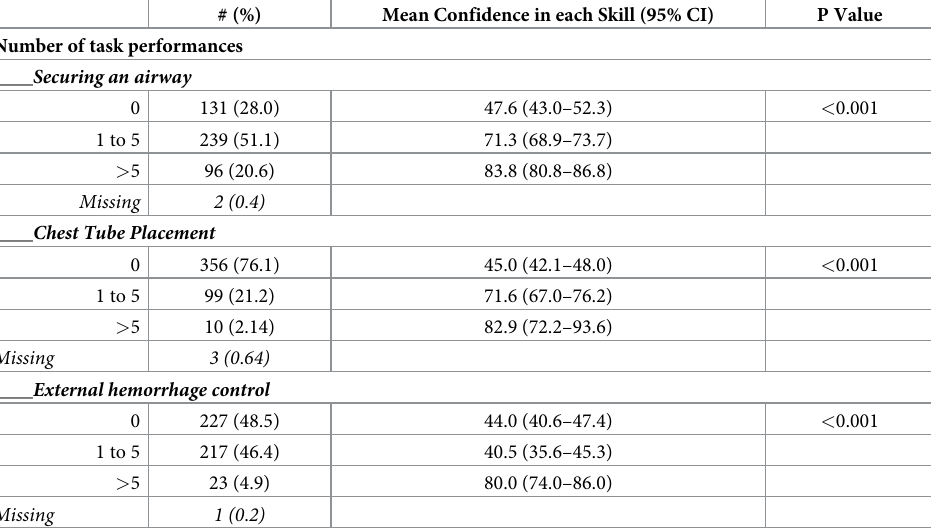
Table 3. Number of times graduating medical students reported completing an emergency management skill dur- ing training and their associated confidence level in that skill compared with one-way